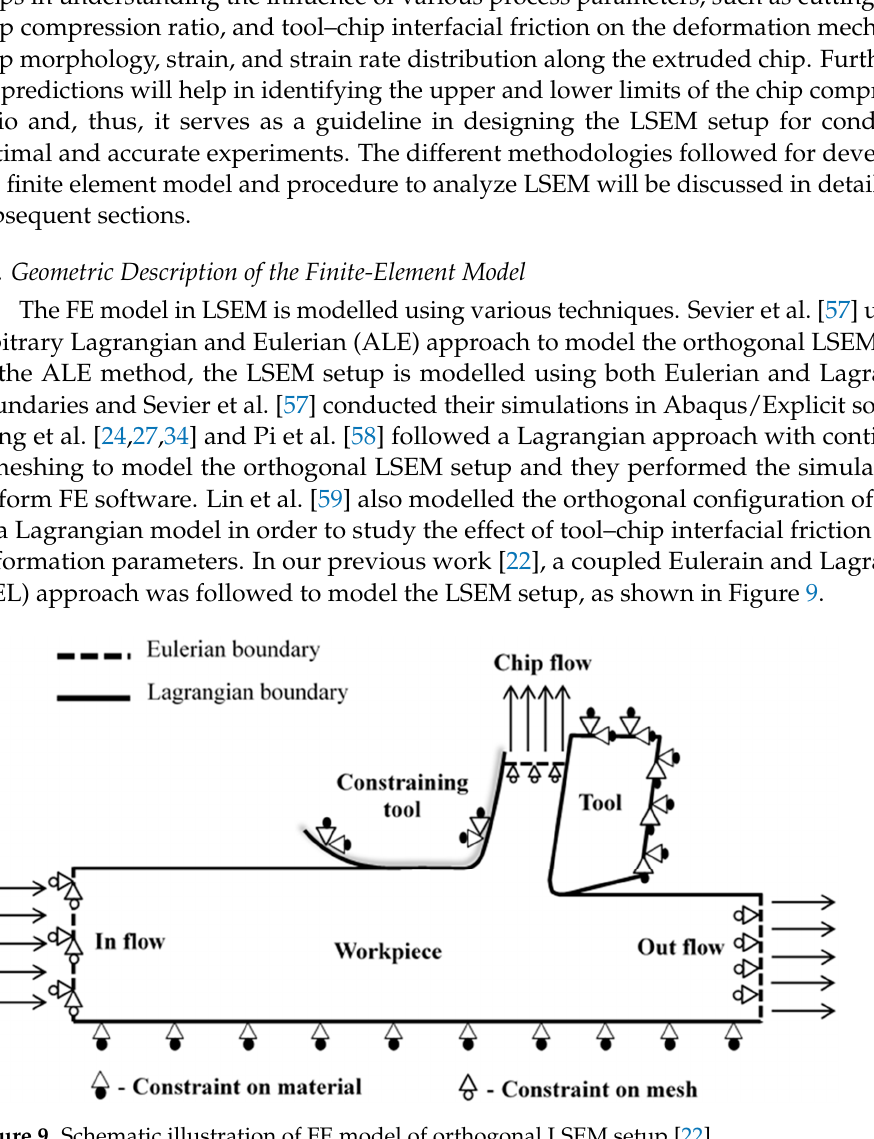
Figure 9. Schematic illustration of FE model of orthogonal LSEM setup